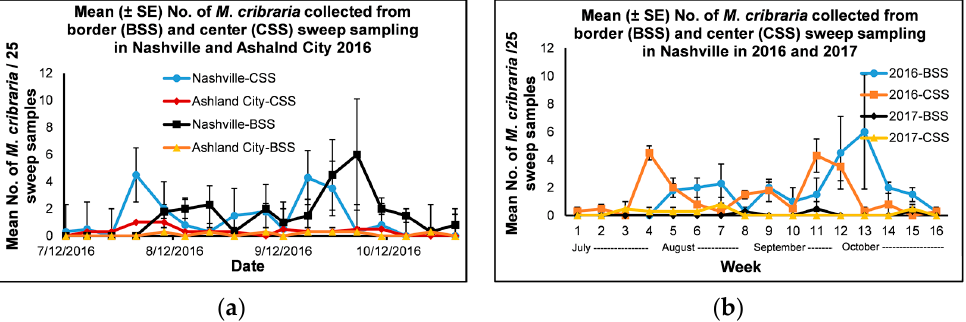
Figure 4. Mean (± SE) number of nymphs and immature Megacopta cribraria per 25 sweep samples collected from border and center sweep sampling in soybeans from ( a ) July to October 2016 conducted in Ashland City (Cheatham County) and Nashville (Davidson County), Tennessee ( b ) July to October 2016 and 2017 in Nashville (Davidson County), Tennessee. Week 1: 7/12/2016 or 7/11/2017, week 2: 7/19/2016 or 7/18/2017, week 3: 7/26/2016 or 7/25/2017, week 4: 8/03/2016 or 8/02/2017, week 5: 8/10/2016 or 8/09/2017, week 6: 8/17/2016 or 8/16/2017, week 7: 8/24/2016 or 8/23/2017, week 8: